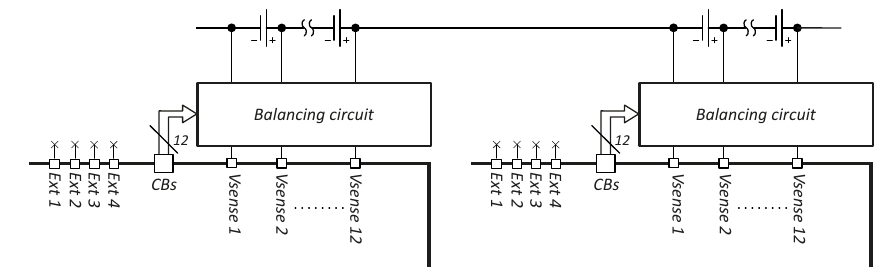
Figure 7. Representation of the balancing circuit.